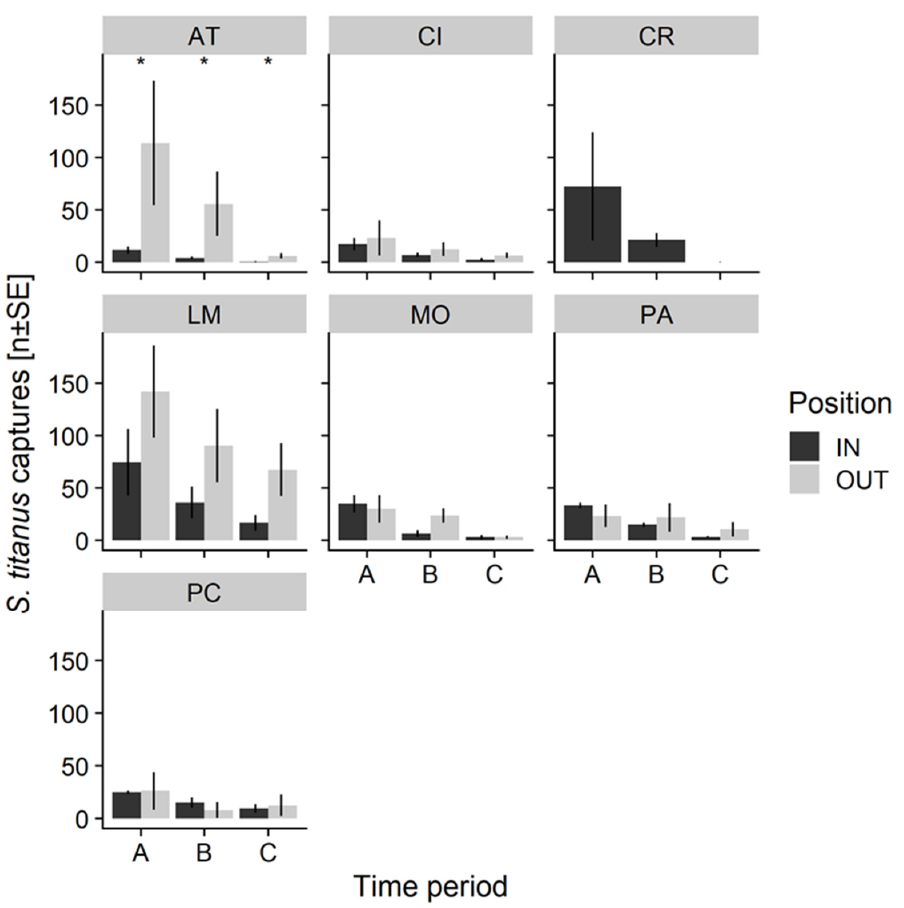
Figure 3. Number of S. titanus adults trapped in the three summer periods ± Standard Error (A = July 10th–July 30th; B = July 31st–August 20th; C = August 21st–September 10th) over the different sampling sites. Inside (IN) and outside (OUT) captures in the same vineyard are represented (Table S2). Asterisk indicates significant difference between the number of S. titanus collected inside and outside the vineyard ( p < 0.05).